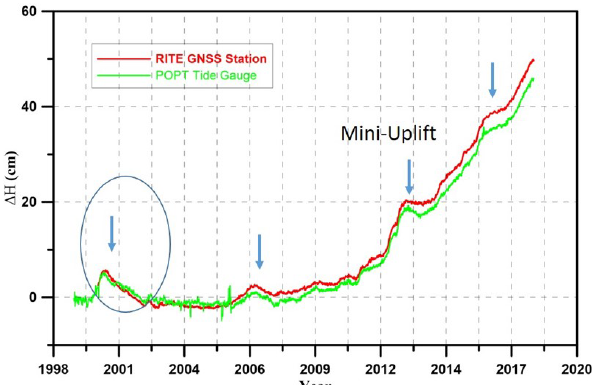
Figure 9. Final tide gauge residual signal (green), namely the ground vertical displacement inferred byfit-remove-deconvolution (see text) at Pozzuoli (POPT). The residual signal is compared to the continuous GNSS data (red line) from RITE, the station closest to the tide gauges. The blue arrows indicate the mini-uplift episode at